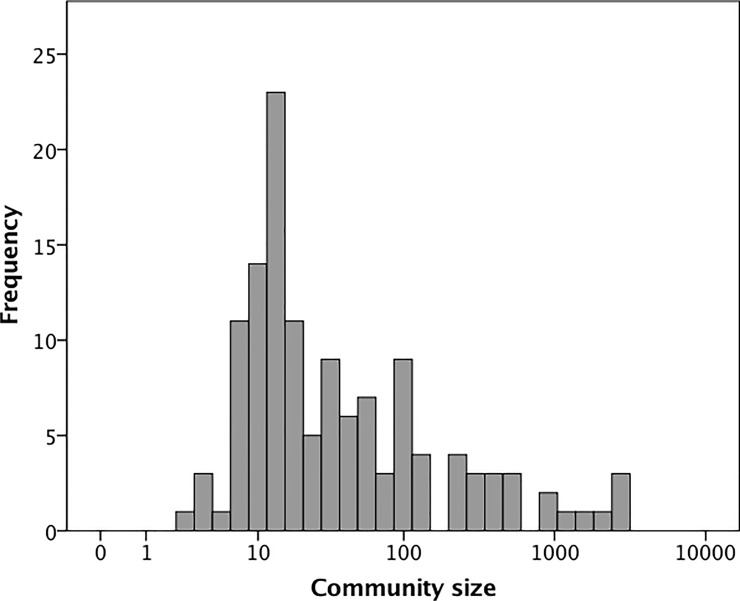
Distribution of Community of Practice (COP) sizes.The X-axis is log10-transformed for illustrative convenience.